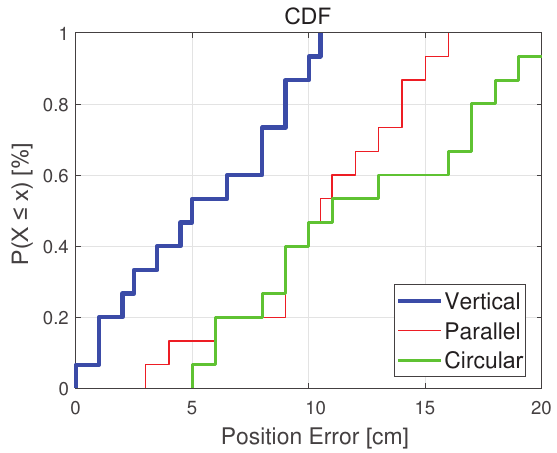
Figure 7. Infuence of different relative-positions on location.